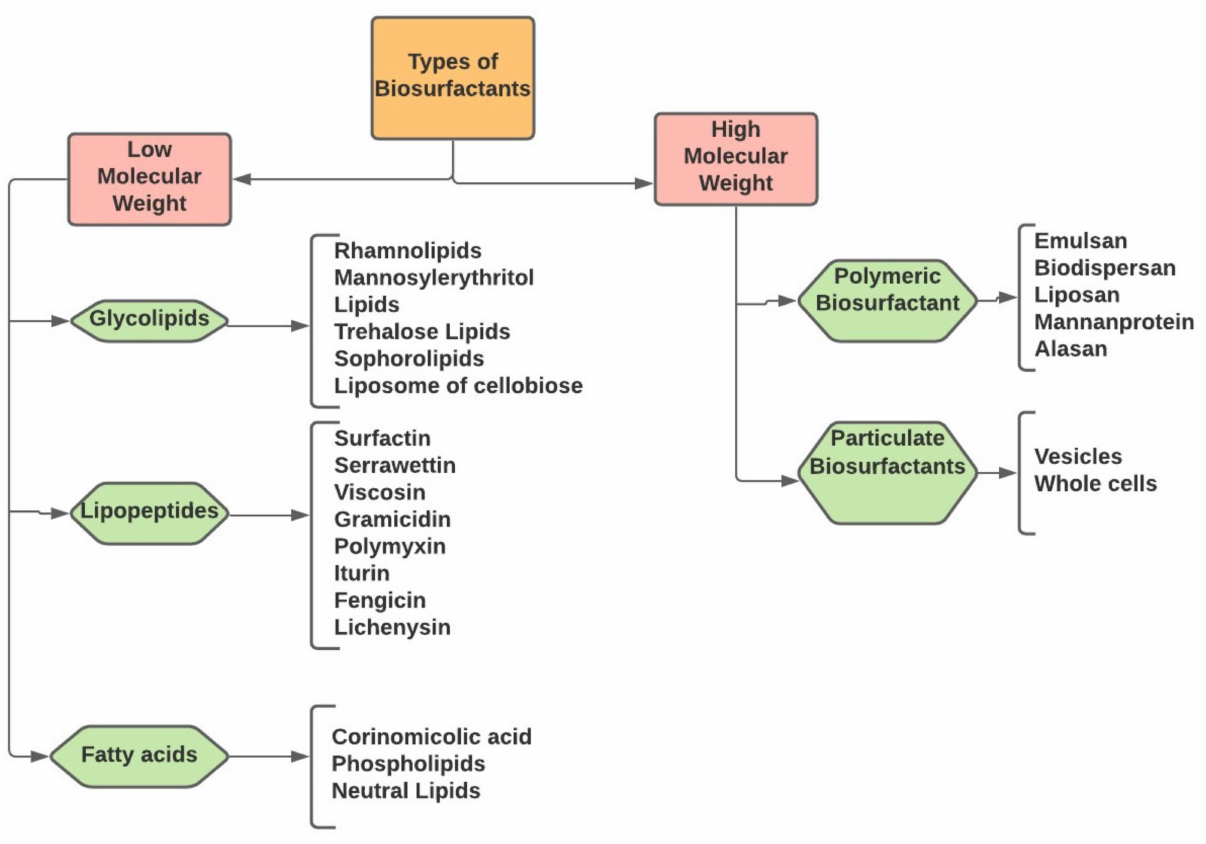
Figure 8. Types of biosurfactant used in various